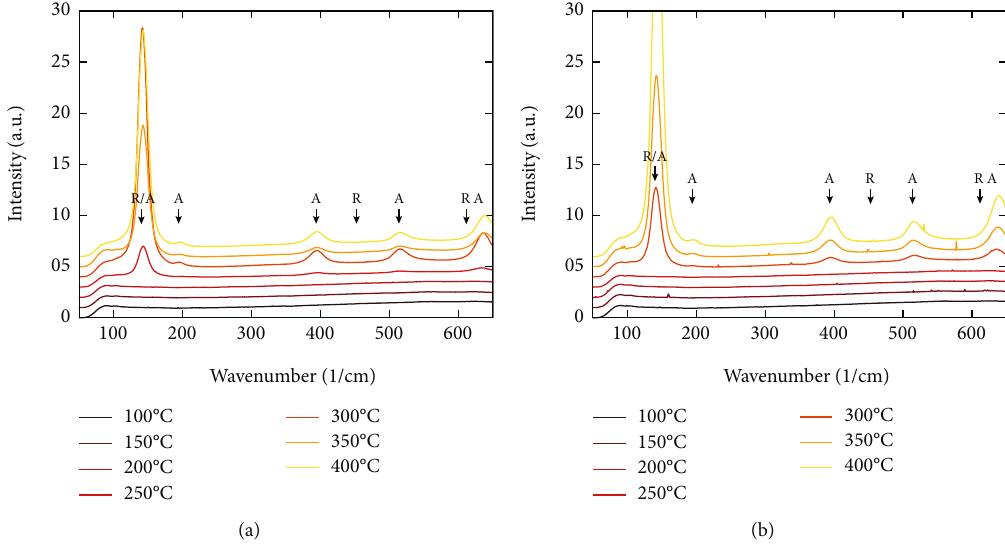
Figure 5: Raman spectra of fabricated TiO anatase (A) and rutile (R) crystal structure. Distinct signals for anatase are observed for temperatures of at least 250 ° C and 300 ° C for H as reactant, respectively. and O 3